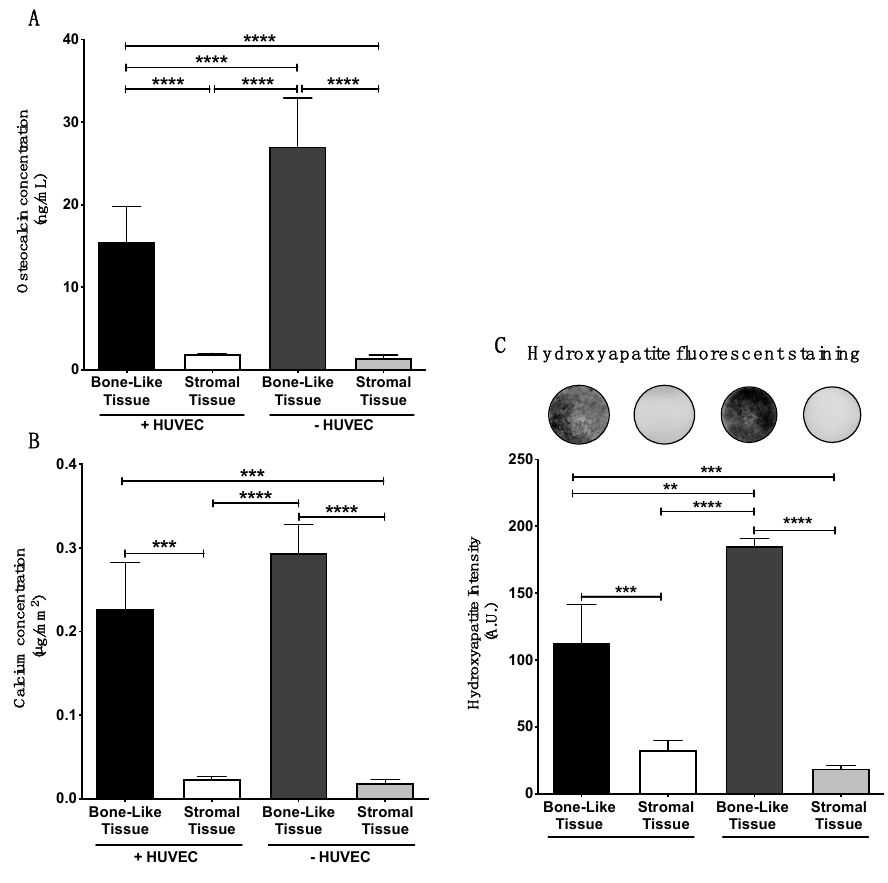
Figure 5. Adding HUVECs diminishes in vitro osteogenesis and biomineralization of the bone-like tissues analyzed after 35 days in culture. The level of human osteocalcin detected by ELISA from tissue lysates is significantly reduced in the prevascularized bone-like tissues ( A ). Calcium content in osteogenically induced tissues, in presence or absence of HUVECs, was significantly elevated compared to their stromal counterparts ( B ). Fluorescent staining of hydroxyapatite in whole tissues was imaged and quantified using a Typhoon Trio+ scanner ( C ). Fluorescent intensity was significantly elevated in bone-like tissues, in presence or absence of HUVECs, compared to their stromal tissue counterparts. One-way ANOVA with a Bonferroni’s multiple comparisons post-hoc test, ** p < 0.01, *** p < 0.001, **** p < 0.0001.